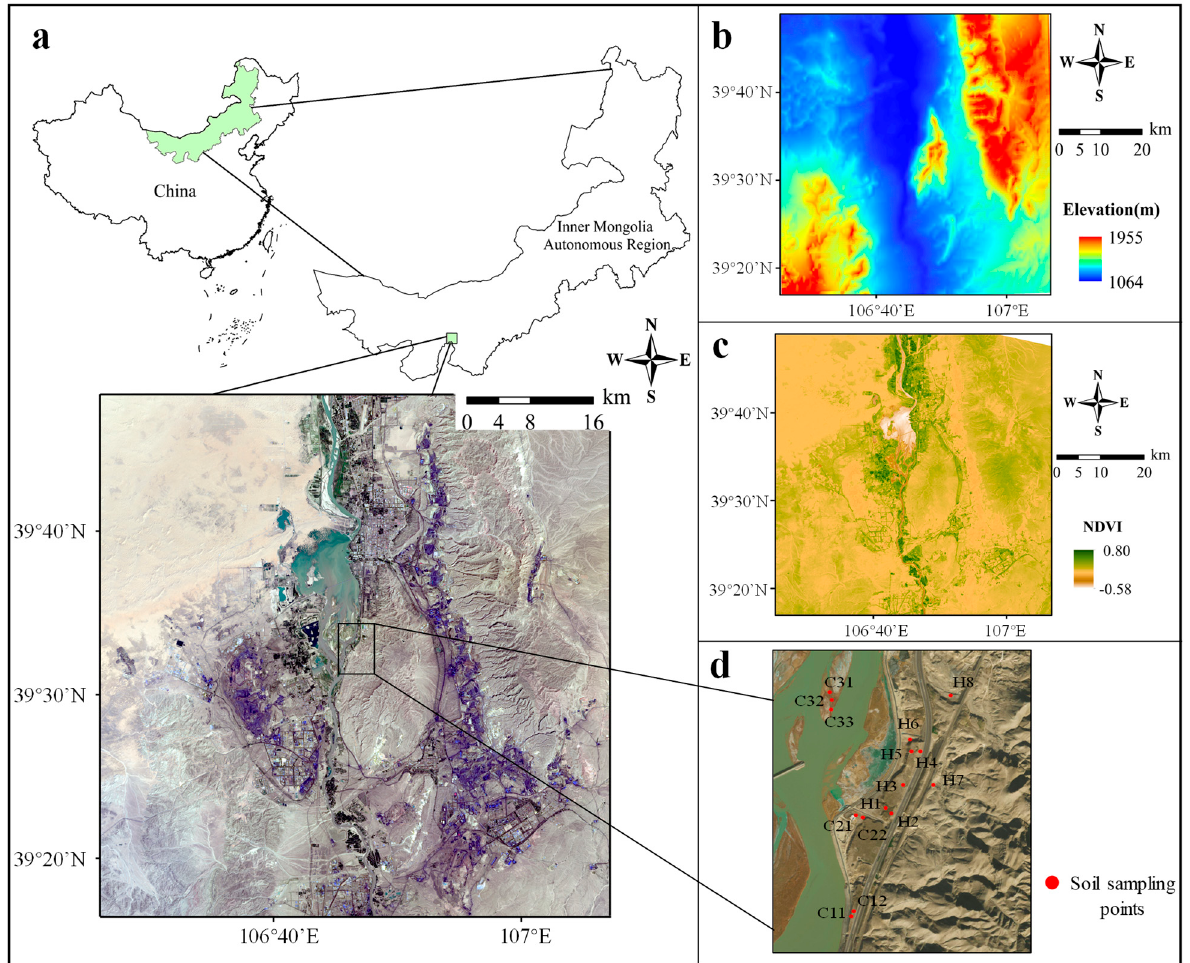
Figure 2. ( a ) Overview map, ( b ) elevation change map, ( c ) NDVI distribution map, and ( d ) soil sampling distribution map of the study area.